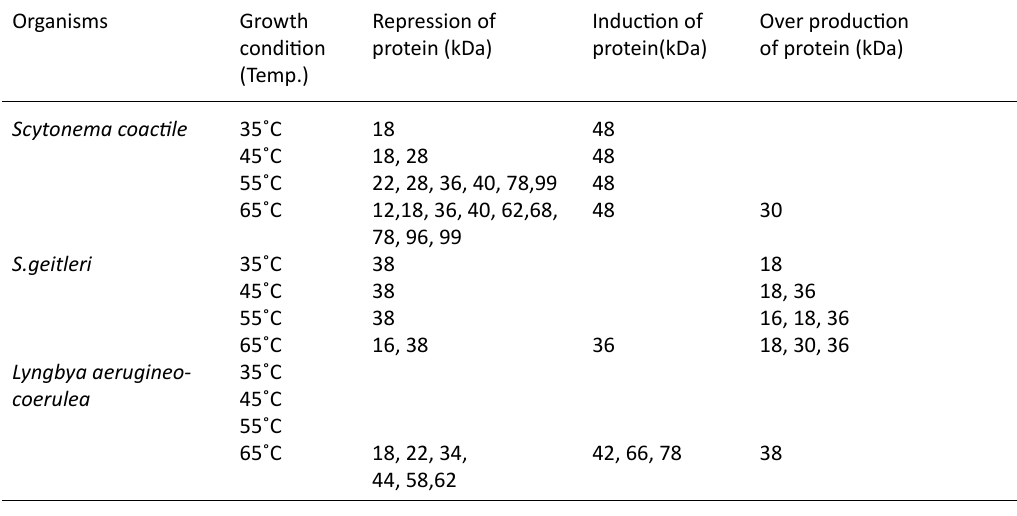
Table 2. Changes in the protein profile of three sub-aerial cyanobacteria strains, S cytonema coactile, S. geitleri and Lyngbya aerugineo-coerulea , after exposure to different duration of temperature (35°C, 45°C, 55°C) for 8 hours and 3 hours at (65°C), and then incubated under continuous illumination (2000 lux) at 28±2°C up to 15 days Organisms Growth Repression of Induction of Over production condition protein (kDa) protein(kDa) of protein (kDa)